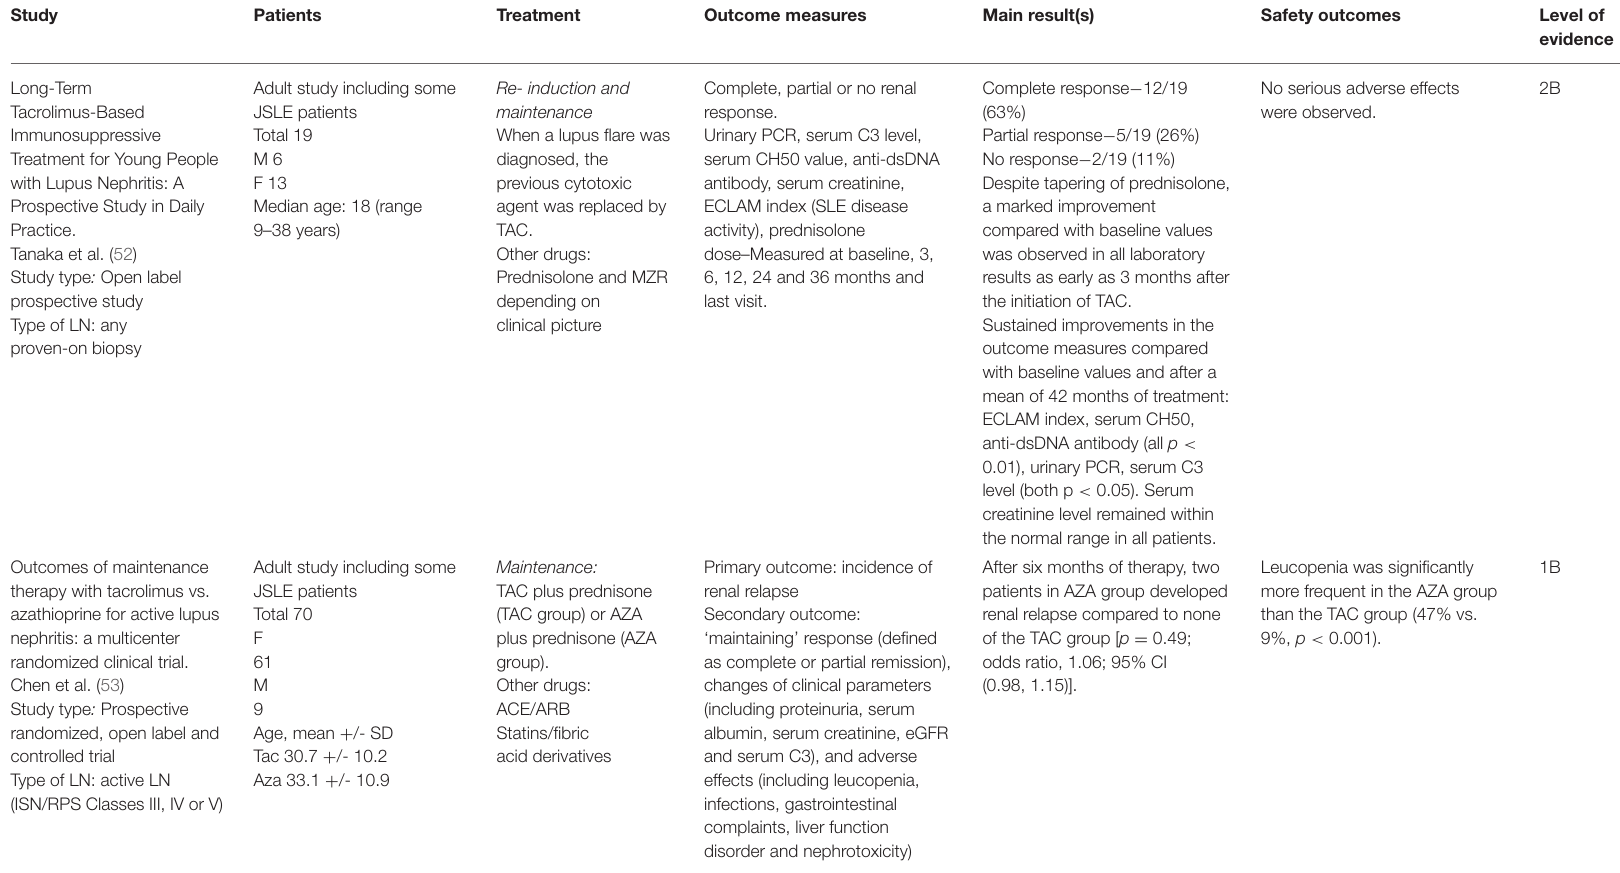
TABLE 4 | Summary of pediatric lupus nephritis treatment studies from 2012 including tacrolimus or mesenchymal stem cell therapy.